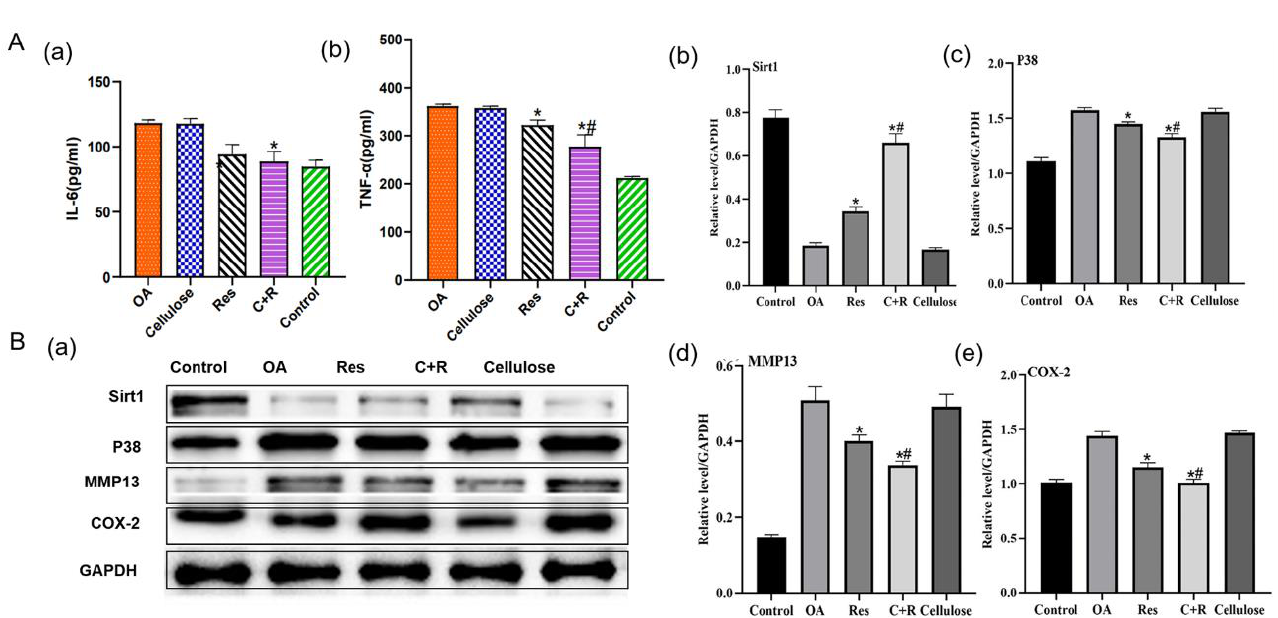
Figure 6. ( A ) Expression of IL-6 ( a ), TNF- α ( b ) in articular fluid of rats (* p < 0.05; *# p < 0.05); ( B ) Expression of Sirt1 ( b ), P38 ( c ), MMP13 ( d ) and COX-2 ( e ) proteins in rat articular cartilage: ( a ) Western blot analysis of several proteins. ( b – e ) Average gray relative value of each protein with GAPDH as internal reference. (* p < 0.05; *# p < 0.05).